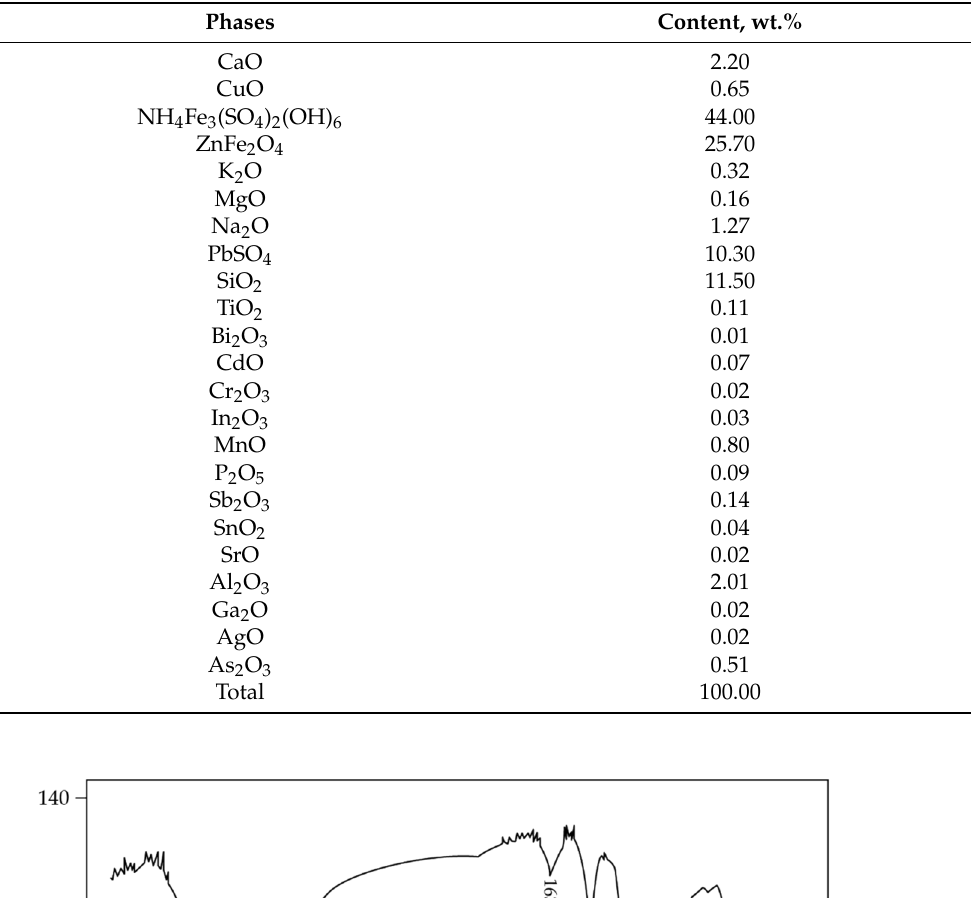
Table 3. The phase composition of the jarosite-PbAg sludge.